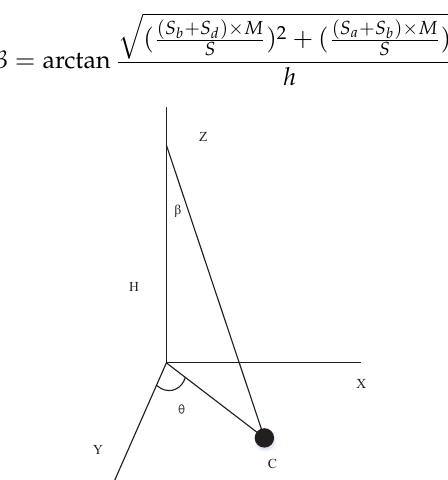
Figure 5. A three-dimensional coordinate when the device is not perpendicular to the